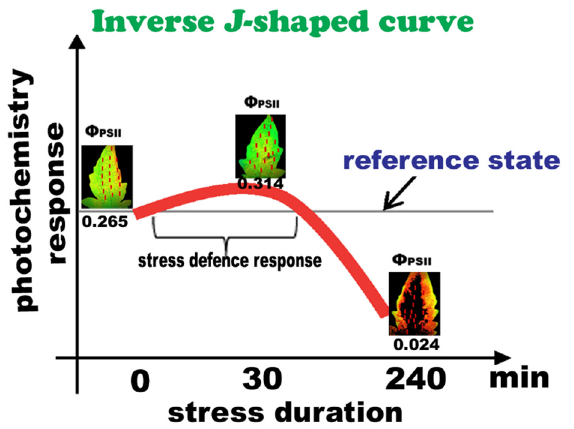
Figure 8. Overview of the hormetic response of photosystem II in tomato (at moderate light intensity), to B. cinerea spore application. The hormetic effect is defined by an inverse J -shaped biphasic curve with a short exposure time to have a stimulatory effect but at longer exposure time severe toxic effects to be apparent.